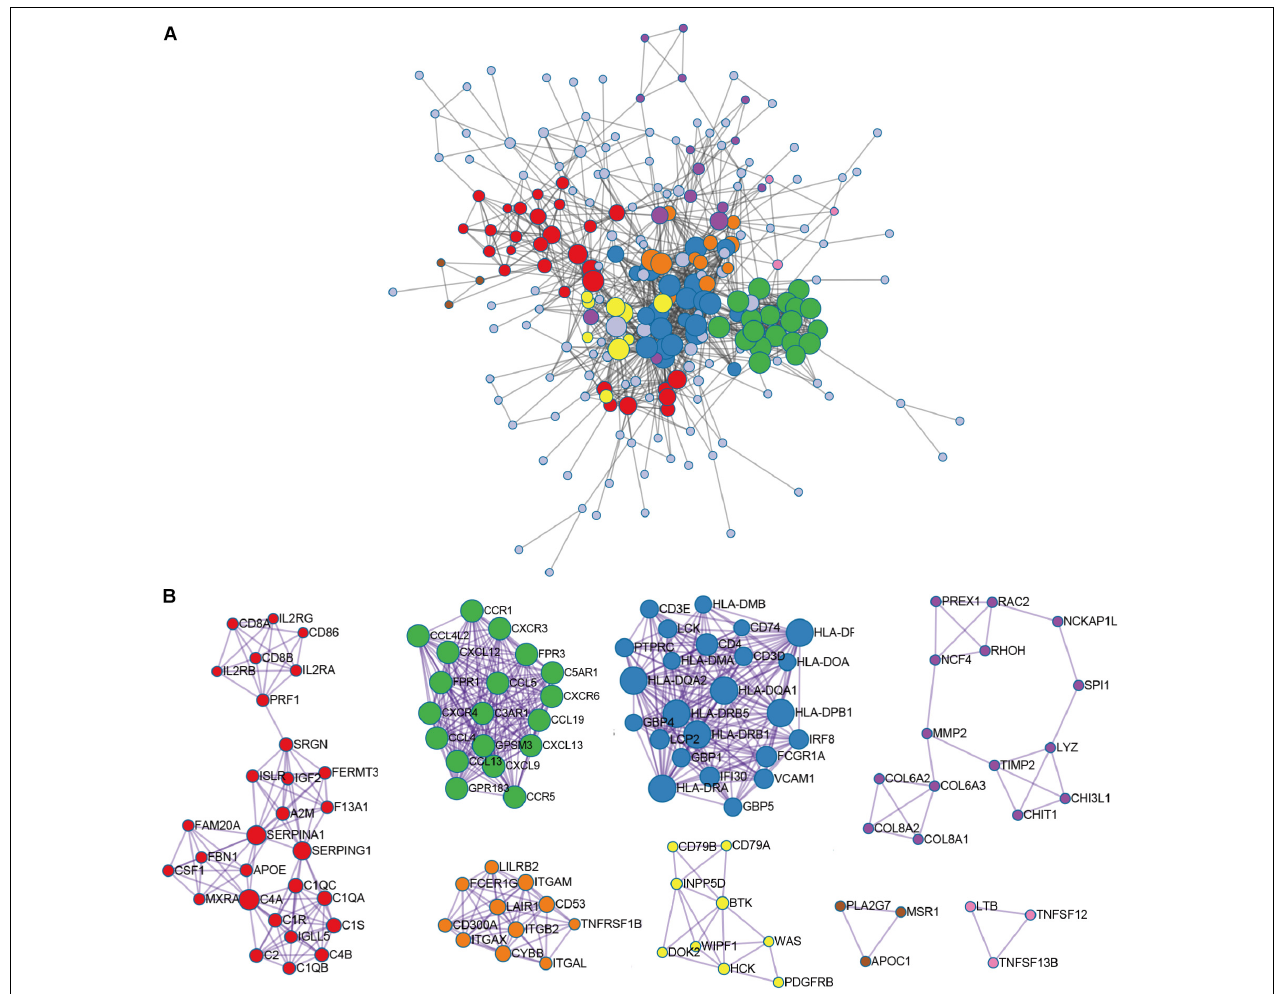
FIGURE 3 | Module-related central genes network in recurrent HNSCC. (A) STRING database and Cytoscape software were used to construct the protein-protein interaction (PPI) network module. In the PPI network, the color of the node reflects the logarithmic (FC) value, the size of the node indicates the number of interacting protein. (B) Through Molecular Complex Detection (MCODE) analysis, eight modules with at least three nodes are determined. The more a gene is associated with other genes in the network, the more relevant the module